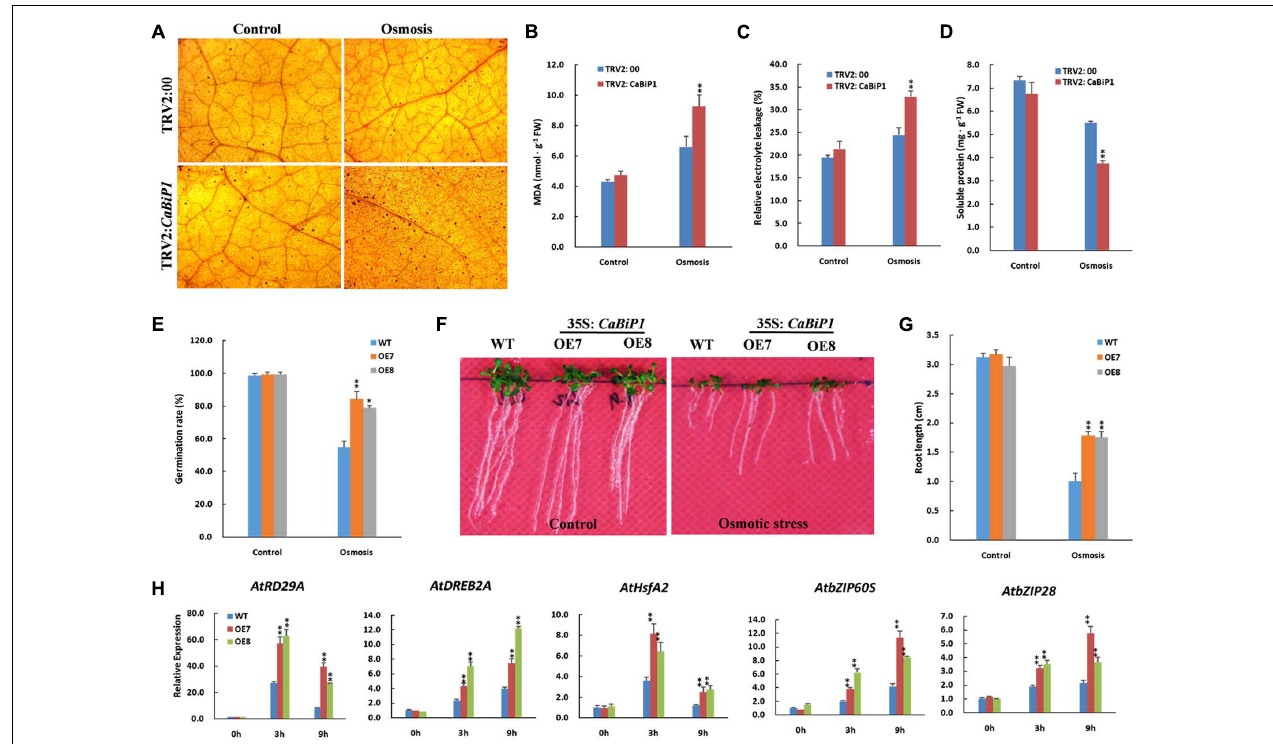
FIGURE 9 | Altered osmotic tolerance in CaBiP1 -silenced and CaBiP1 -overexpressing plants. (A–D) H 2 O 2 accumulation, REL, MDA content, and soluble protein content in TRV2:00 and TRV2: CaBiP1 pepper seedlings leaves grown under osmotic stress simulated by soaking in 300 g/L PEG6000 for 24 h. Treatment with distilled water was used as the control. (E) Seed germination rate of WT and CaBiP1- OE lines grown under osmotic stress by adding 200 mM mannitol in the medium for 4 days. (F,G) Root growth of WT and transgenic Arabidopsis lines germinated under 150 mM mannitol for 7 days. (H) Expression of osmotic stress- and ER stress-related genes in the leaves of 3-week-old WT and CaBiP1 -OE hydroponic seedling grown under 300 mM mannitol for designed time duration. AtActin2 was used as the internal control gene. Data are the mean ± standard deviation from three biological replicates. Statistical significance is indicated by a single asterisk ( p < 0.05) and a double asterisk ( p < 0.01) based on the results of the Student’s t